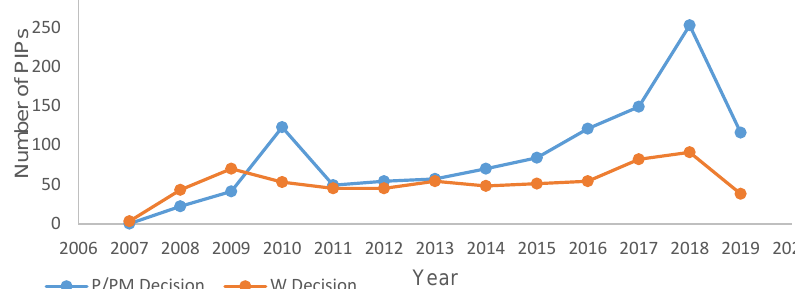
Figure 3. Number of positive (P/PM) PIP decisions and waivers (W) granted per year by the PDCO, since the EUPR was established in 2007. Data from 2007 and 2019 correspond to incomplete years (February to December 2007 and January to October 2019). Data taken from EMA repository